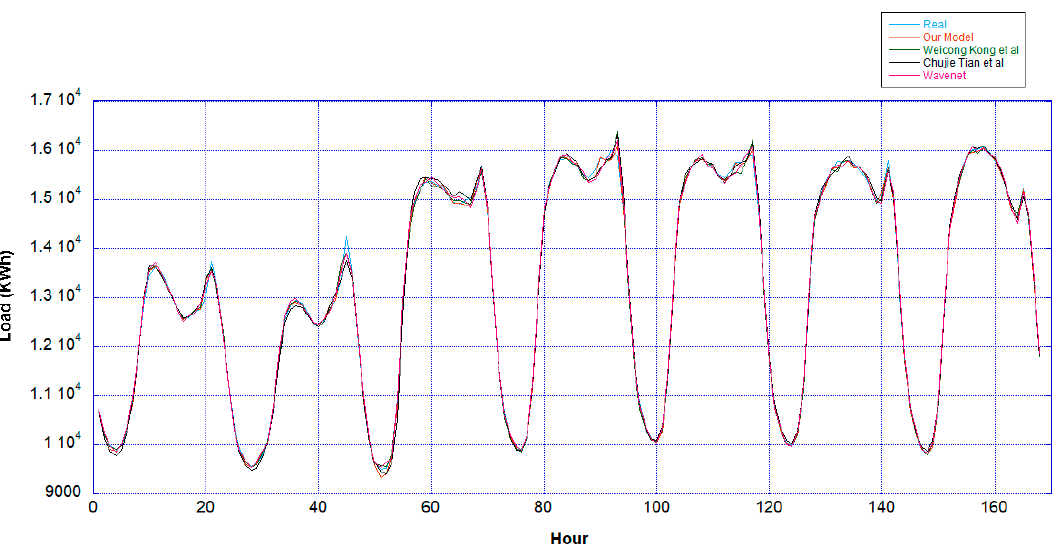
Figure 12. Forecasting result using ISO-NE dataset 2.